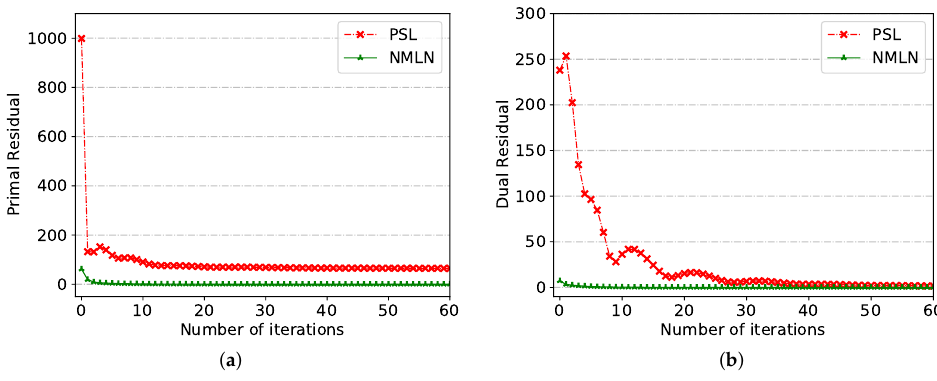
Figure 4. Evaluation of convergence on NMLN vs. PSL: ( a ) primal residual; ( b ) dual